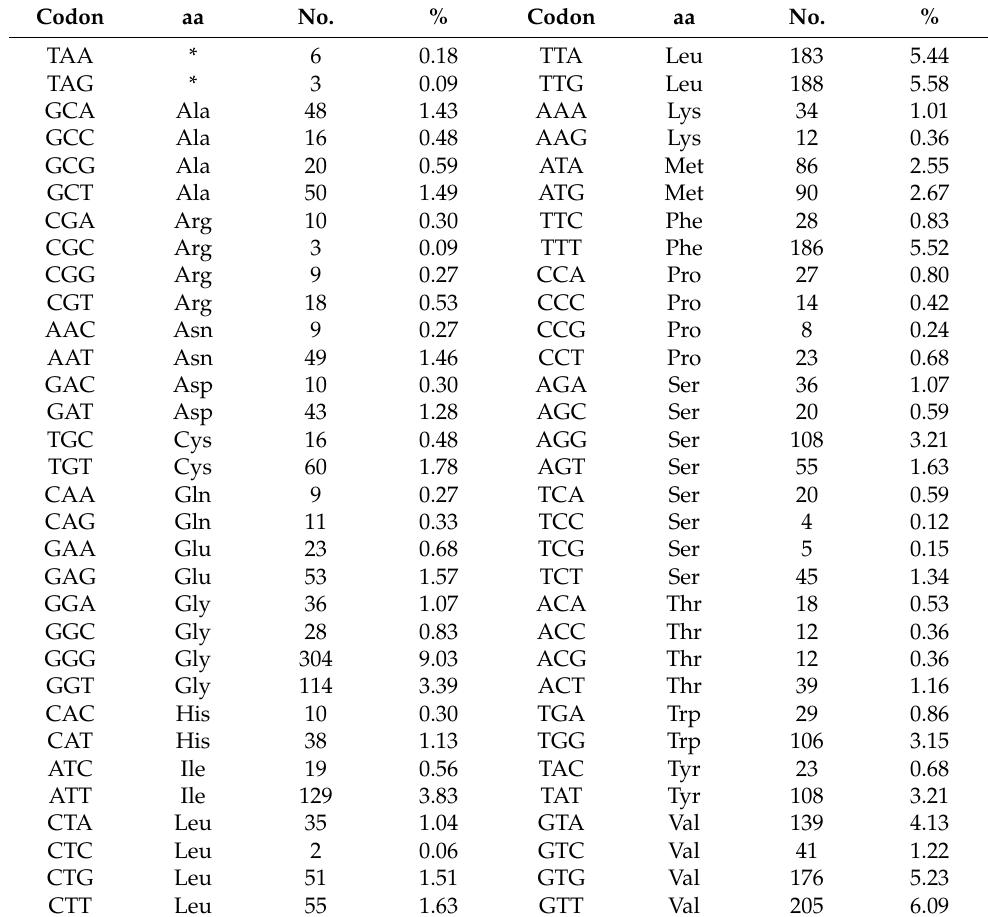
Table 6. Relative synonymous codon usage (RSCU) of Pseudoacanthocephalus bufonis (The asterisk represents termination